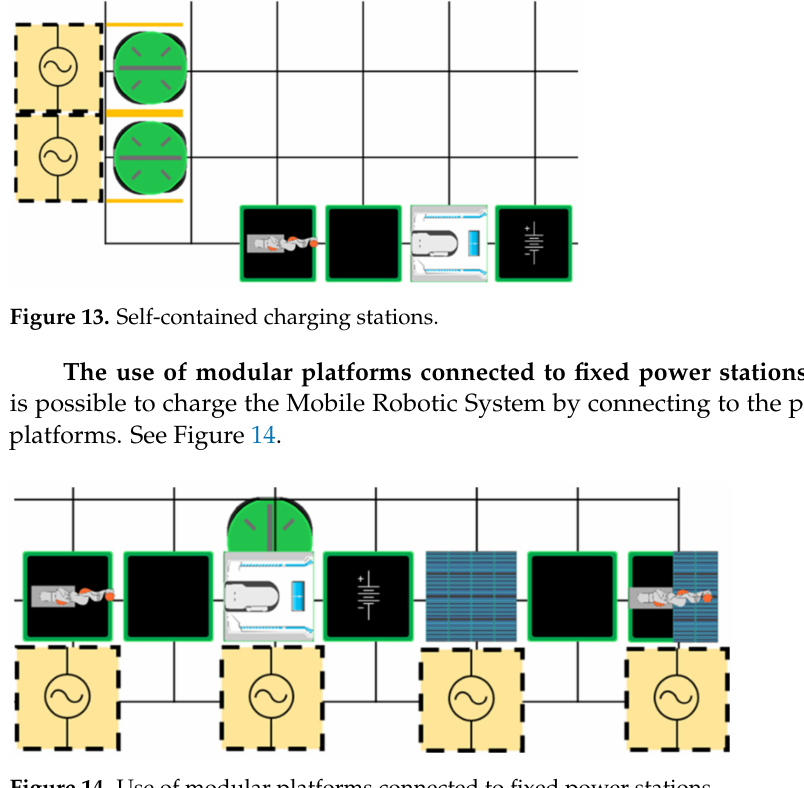
Figure 14. Use of modular platforms connected to fixed power